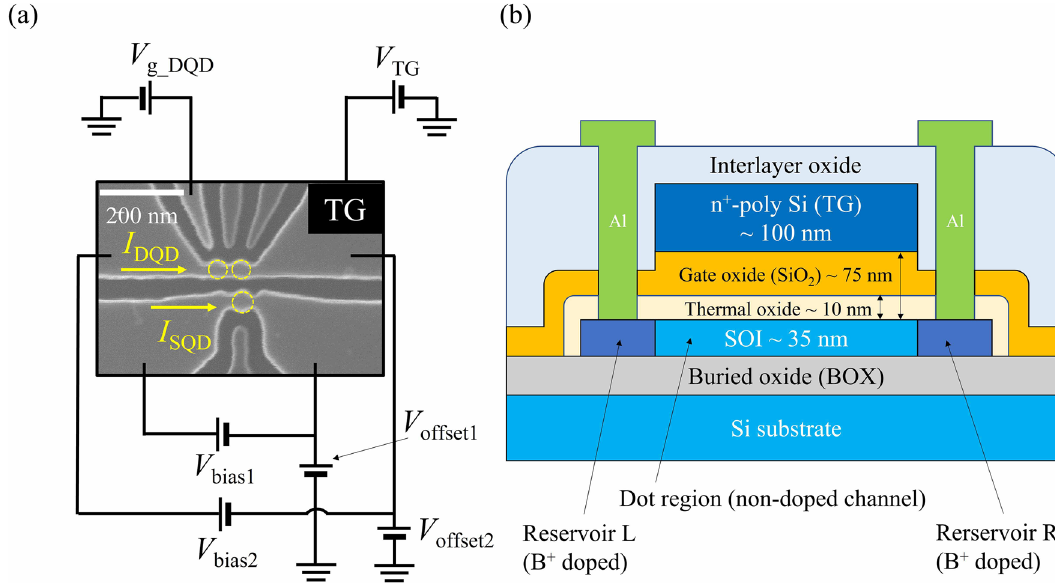
Figure 1. ( a ) A scanning electron micrograph (SEM) of the physically defined QD device. QDs in this device are indicated by yellow dashed circles. A single QD (SQD) located next to a double QD (DQD) is usually used as a charge sensor to observe the charge states in the DQD. ( b ) A cross-sectional schematic of the device structure. A poly-Si top gate on a 75 nm-thick SiO 2 layer covers the QD region. Boron ions are implanted at the outside region where the top gate does not cover silicon on insulator (shown by dark blue region).